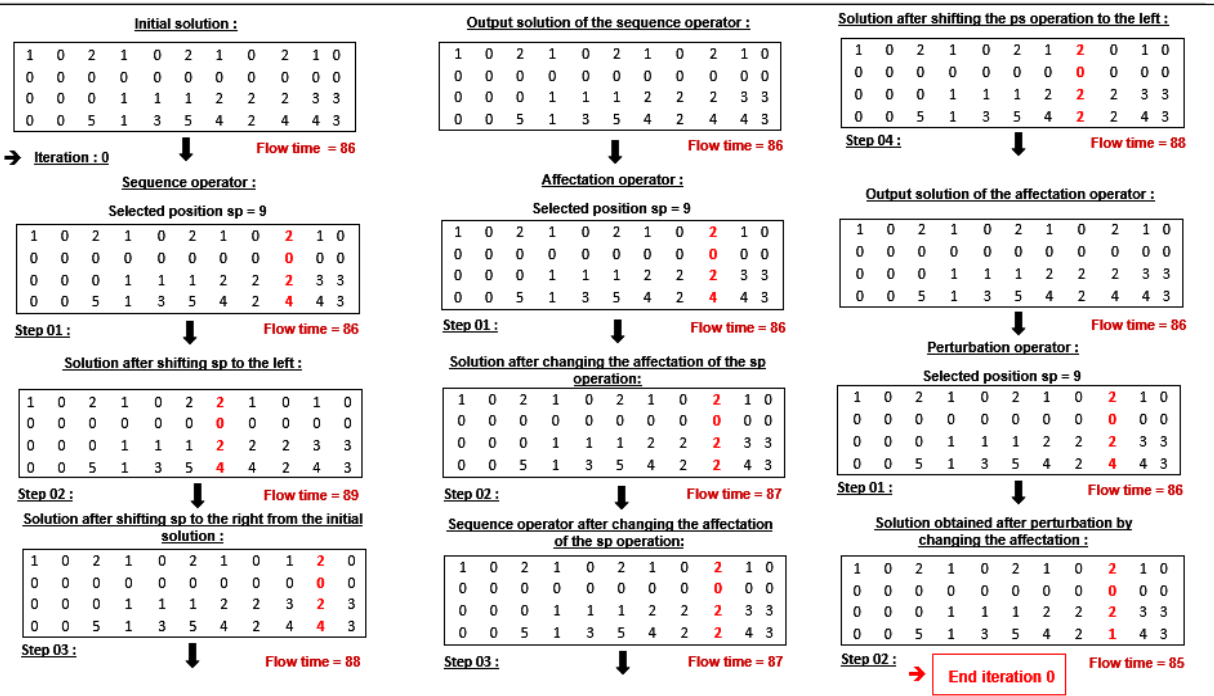
Figure 9. Steps of the iterative local search algorithm for one